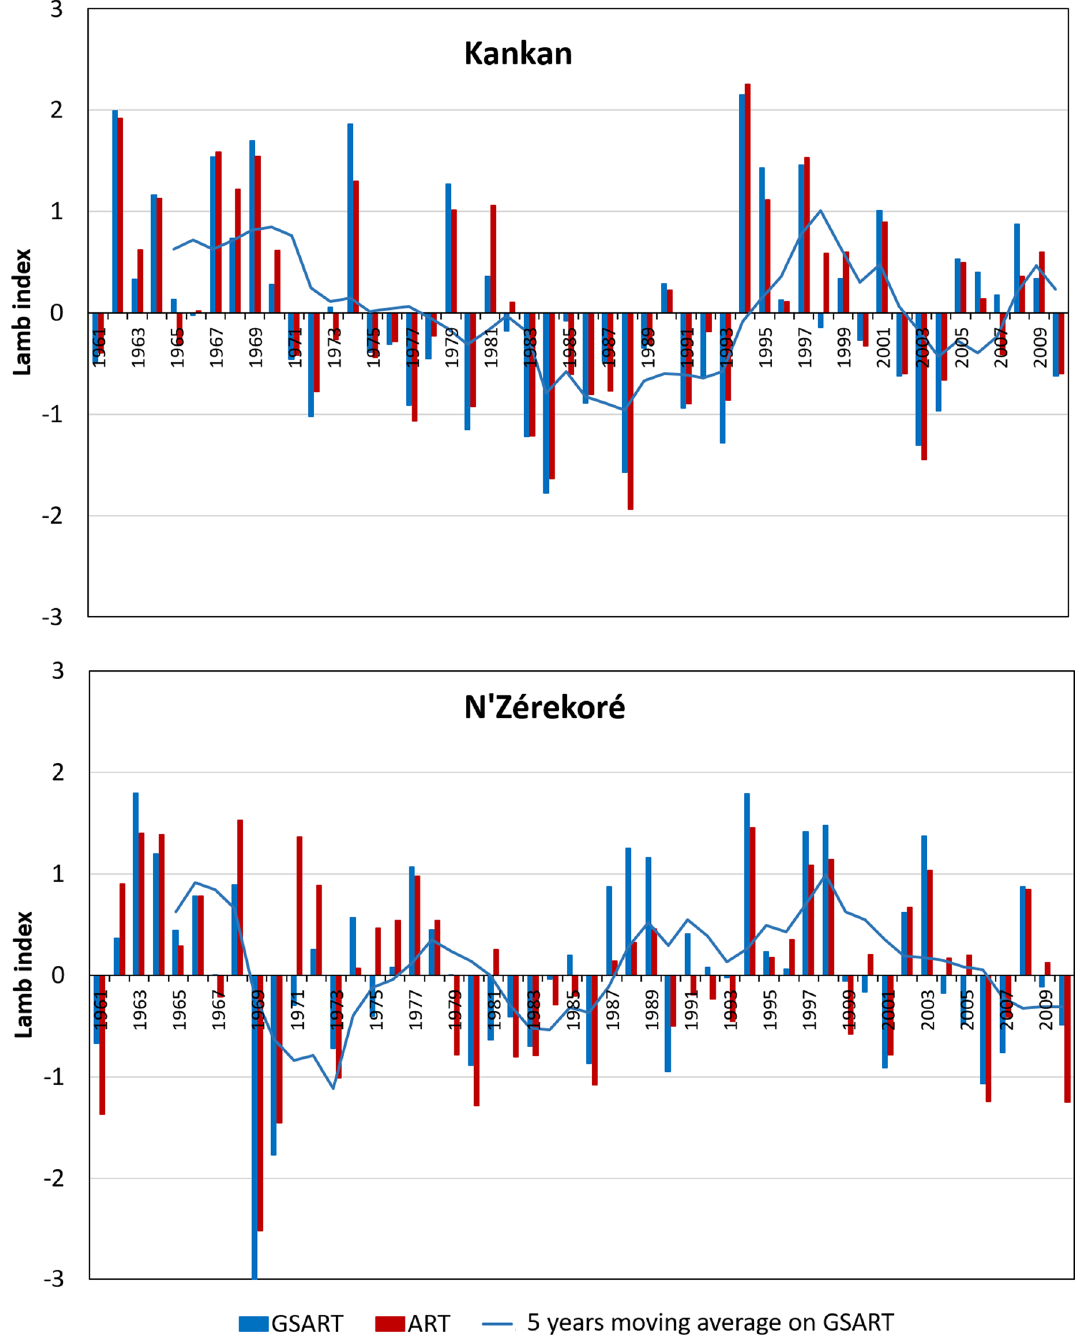
Fig. 1 Pattern of deviation of the annual rainfall total during the crop growth season (GSART) from the normal reference, during the 1961–2010 period, in Kankan (10°23 ′ 01.65 ″ N; 9°18 ′ 18.72 ″ W) and N’Zérekoré (7°’48 ′ 53.2 ″ N; 8°42 ′ 14.11 ″ W) sites of